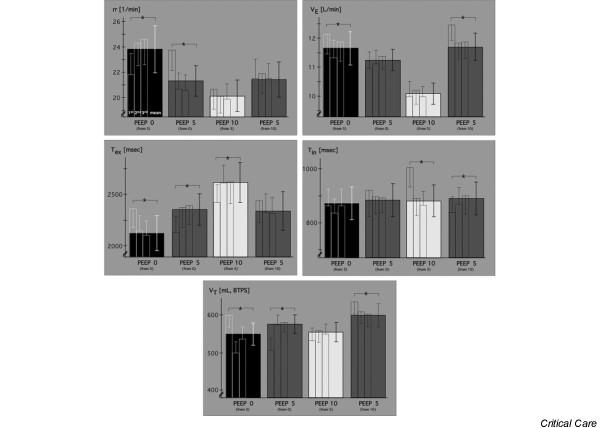
Changes of breathing pattern in the first, second and third breath after steps of PEEP. Results are from the investigation with PEEP steps of 30 s duration. The shaded areas represent averaged values of all breath for the corresponding PEEP level; open bars indicate the first, second, and third breath after changes of PEEP. Values are expressed as means ± 1 standard error of the mean (SEM). Note that changes of breathing pattern were beginning to manifest within the first breath and became fully established in the second breath after both upward and downward steps in PEEP. *P < 0.025, versus mean values within the corresponding PEEP level. BTPS, body temperature pressure, (water damp) saturated; PEEP, positive end-expiratory pressure; rr, respiratory rate; Tex, expiratory time; Tin, inspiratory time; VE, minute ventilation.